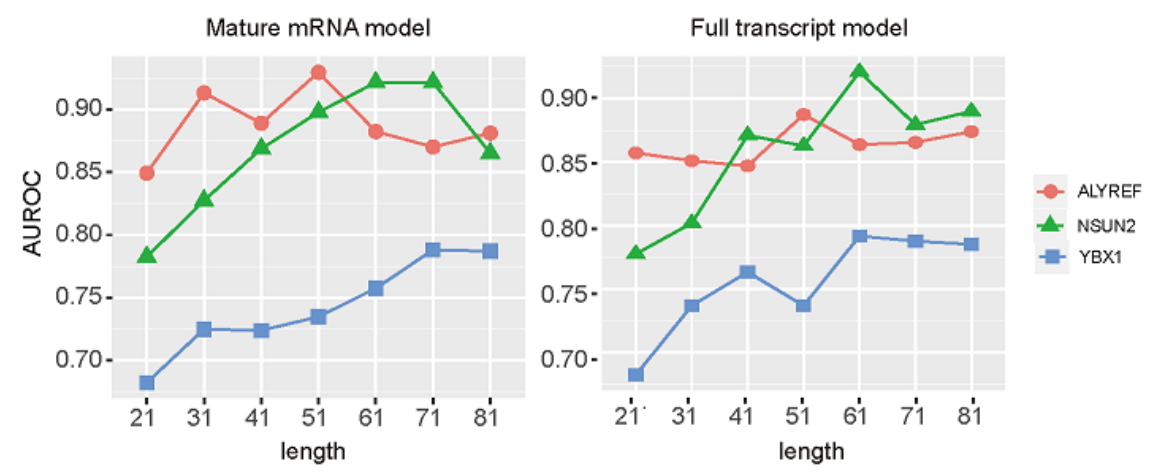
Figure 3. Performance of different length windows with PSNP encoding method.